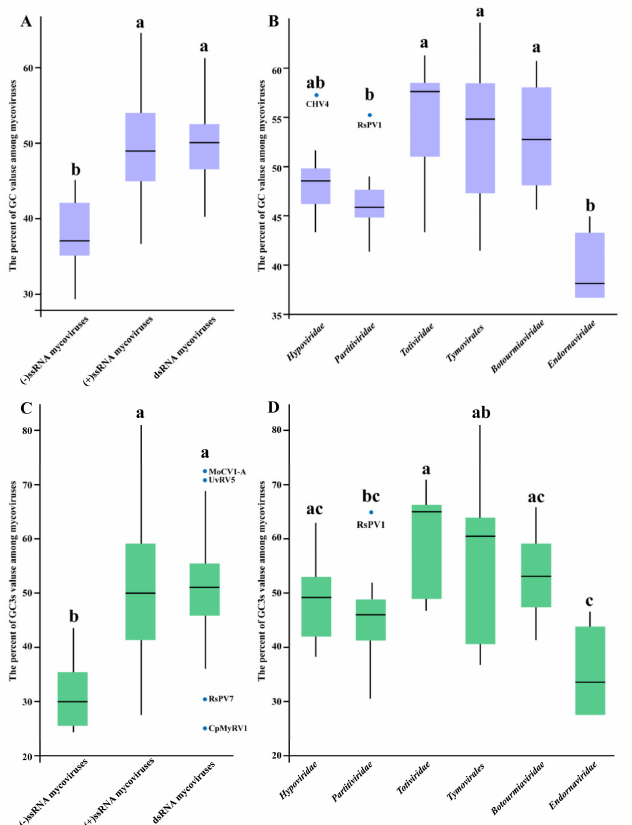
Figure 1. Comparative analysis of the GC and GC3s (the frequency of the third nucleotides G + C in the synonymous codons) contents in different mycoviruses. The x -axis represents ( − )ssRNA, (+)ssRNA, and dsRNA mycoviruses in ( A , C ) and represents the Hypoviridae , Partitiviridae , Totiviri- dae , Tymovirales , Botourmiaviridae , and Endornaviridae mycoviruses in B and D. The y -axis represents the percent of GC values ( A , B ) and GC3s values ( C , D ) among ( − )ssRNA, (+)ssRNA, and dsRNA mycoviruses ( A , C ), and Hypoviridae , Partitiviridae , Totiviridae , Tymovirales , Botourmiaviridae , and En- dornaviridae mycoviruses ( B , D ). Statistical significance was determined by the LSD test. Different lowercase letters in the graph indicate statistical differences ( p < 0.05), the statistical difference is not significant with same lowercase letter, and the different lowercase letters represent significant statistical